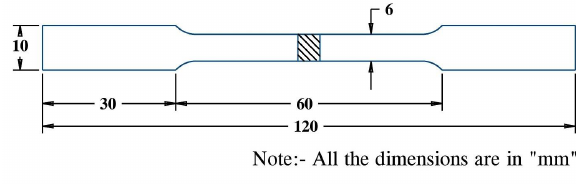
Figure 4: Dimensions of the transverse tensile specimen extracted from the welded joints